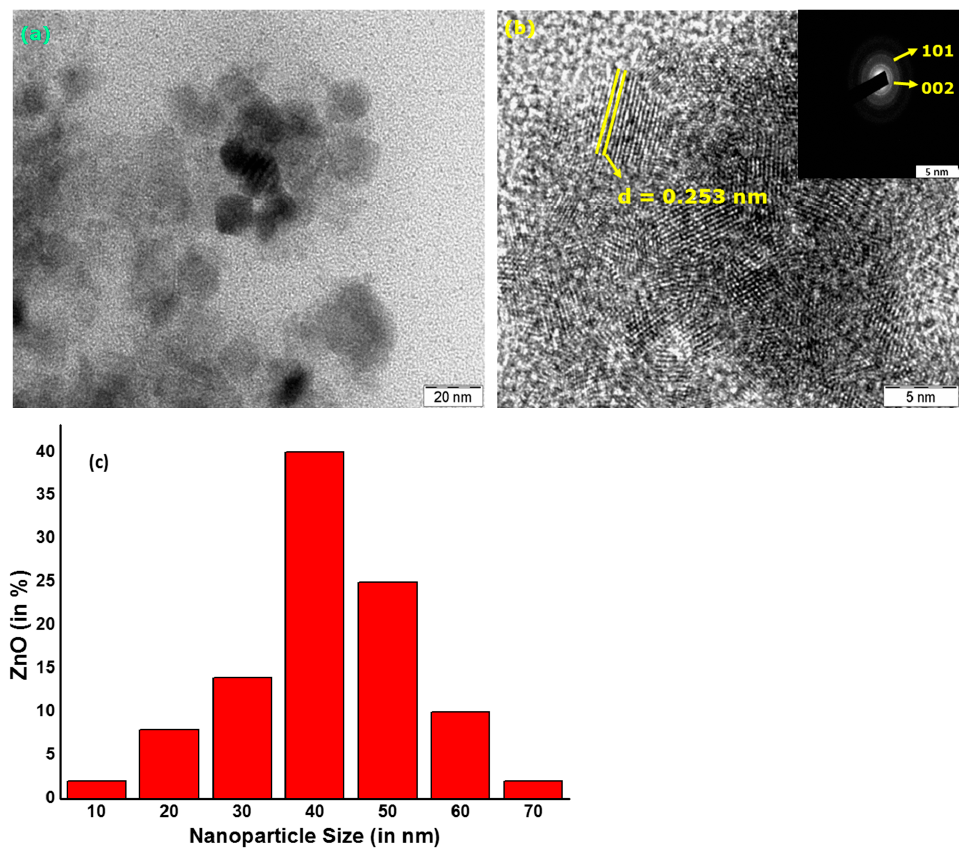
Figure 5. ( a ) TEM image and ( b ) HRTEM showing the SAED (inset) and ( c ) a histogram revealing the size distribution of the as-obtained